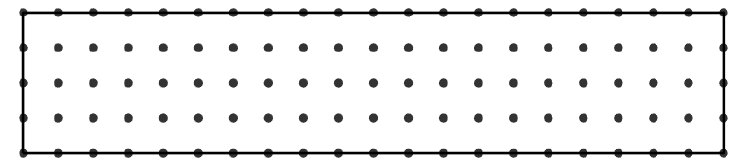
Figure 6. The nodal distribution for a cantilever beam.